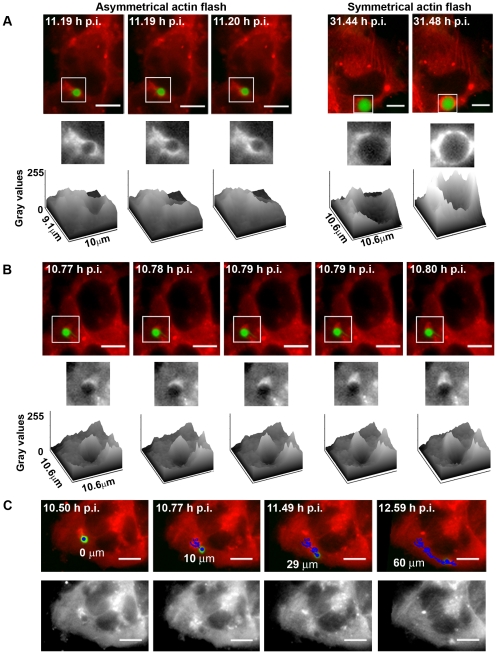
Dynamics of hepatocyte actin clouds around developing P. berghei.Asymmetrical and symmetrical actin clouds (A) as well as tail-like actin clouds (B) are present around GFP-Pb (red and grey: mCherry::β-actin; green: GFP-Pb), surface plots represent the intensity of the pixels of the mCherry::β-actin channel in the selected region (square). (C) Translocation of a GFP-Pb, associated with a tail-like actin cloud. The tracked path is indicated in blue (red and grey: mCherry::β-actin; green: GFP-Pb). Scale bars represent 10 µm. Some frames present the same time points as the acquisition interval between individual images was 20 s ( = 0.0056 h) and thus too small to annotate in consecutive frames, when using a time scale of hours.